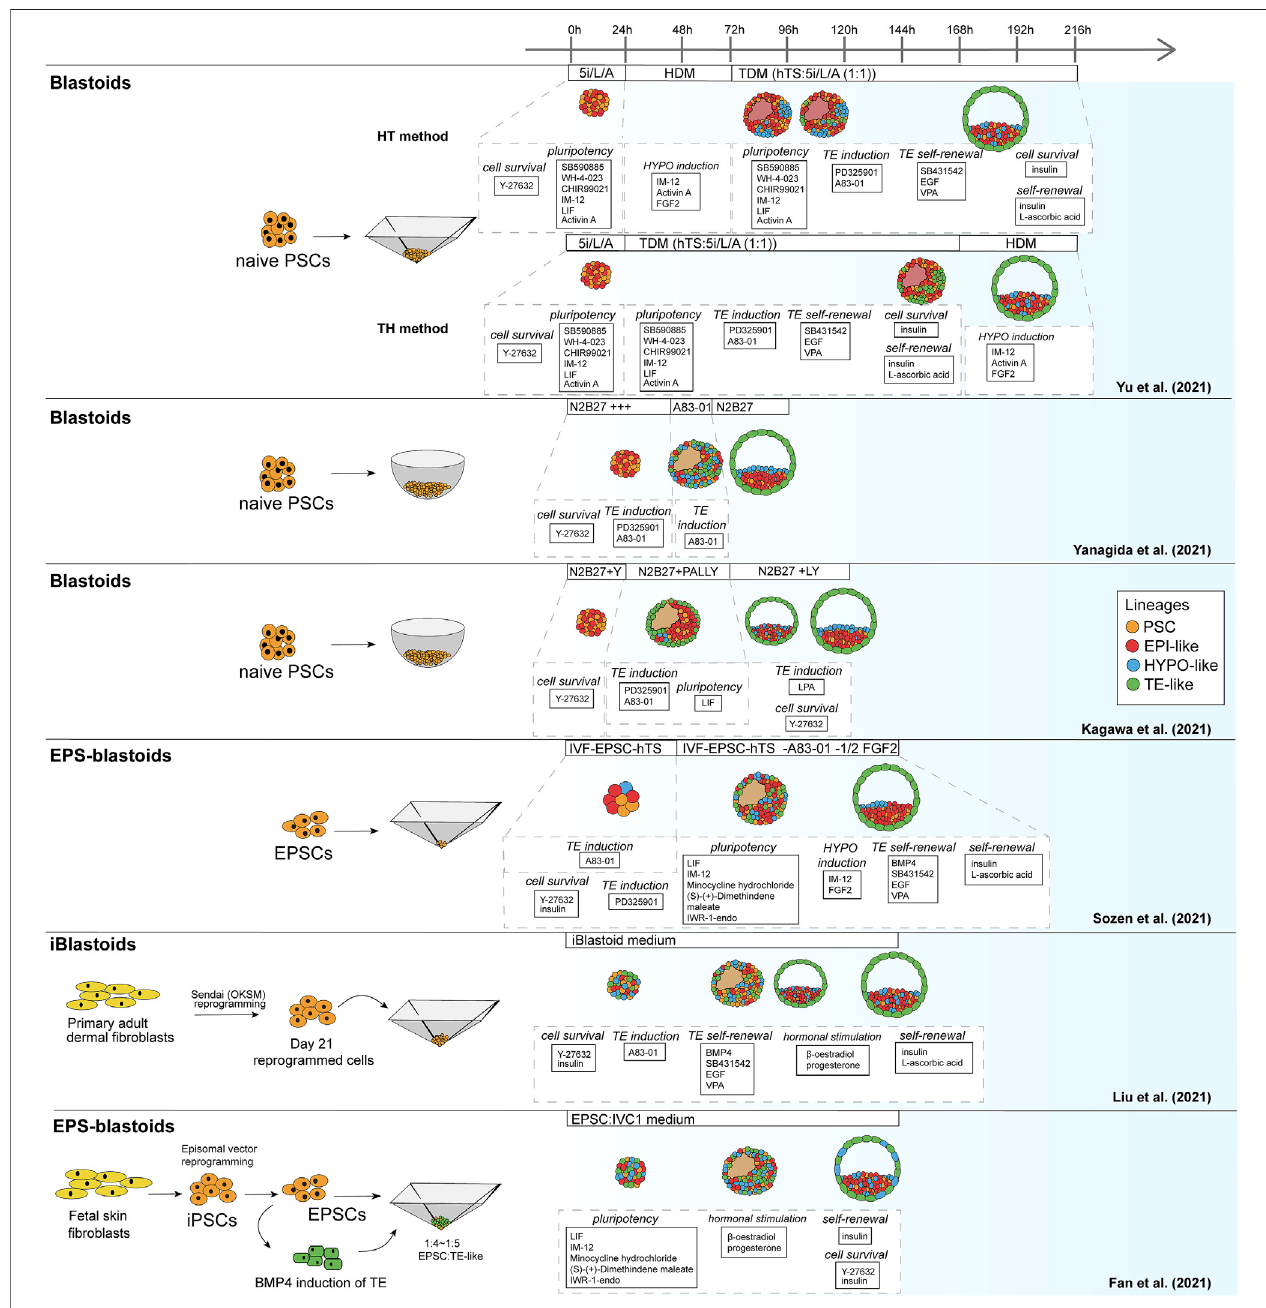
FIGURE 2 | Schematic of human blastoid protocols. The names attributed to the models are taken from the original publications.